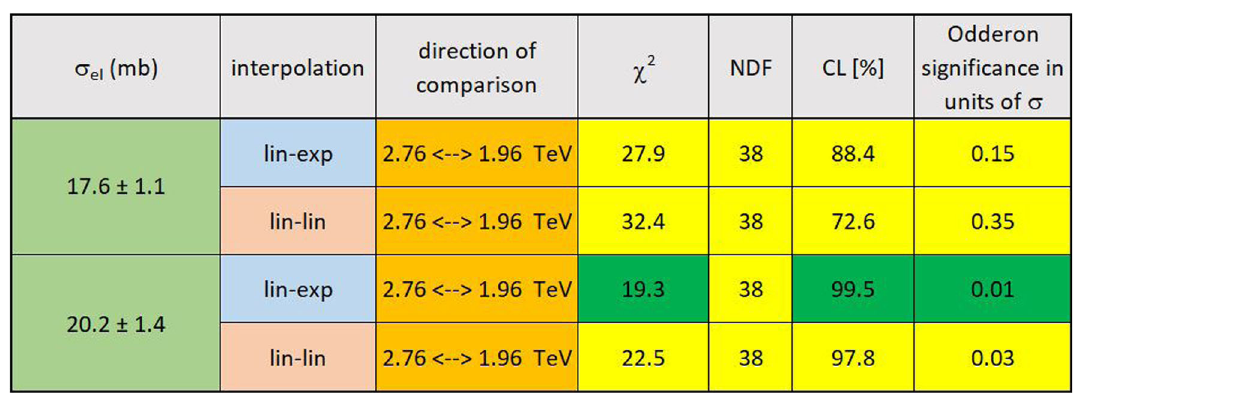
Table 5 Summary table of the search for an Odderon signal in the two-way comparison of the H ( x ) scaling functions of pp collisions at √ s = 2 . 76 TeV, measured by the TOTEM experiment at the LHC, and √ p ¯ p elastic collisions at s = 1 . 96 TeV, measured by the D0 experi- ment at Tevatron. The lowest value of significance in this comparison